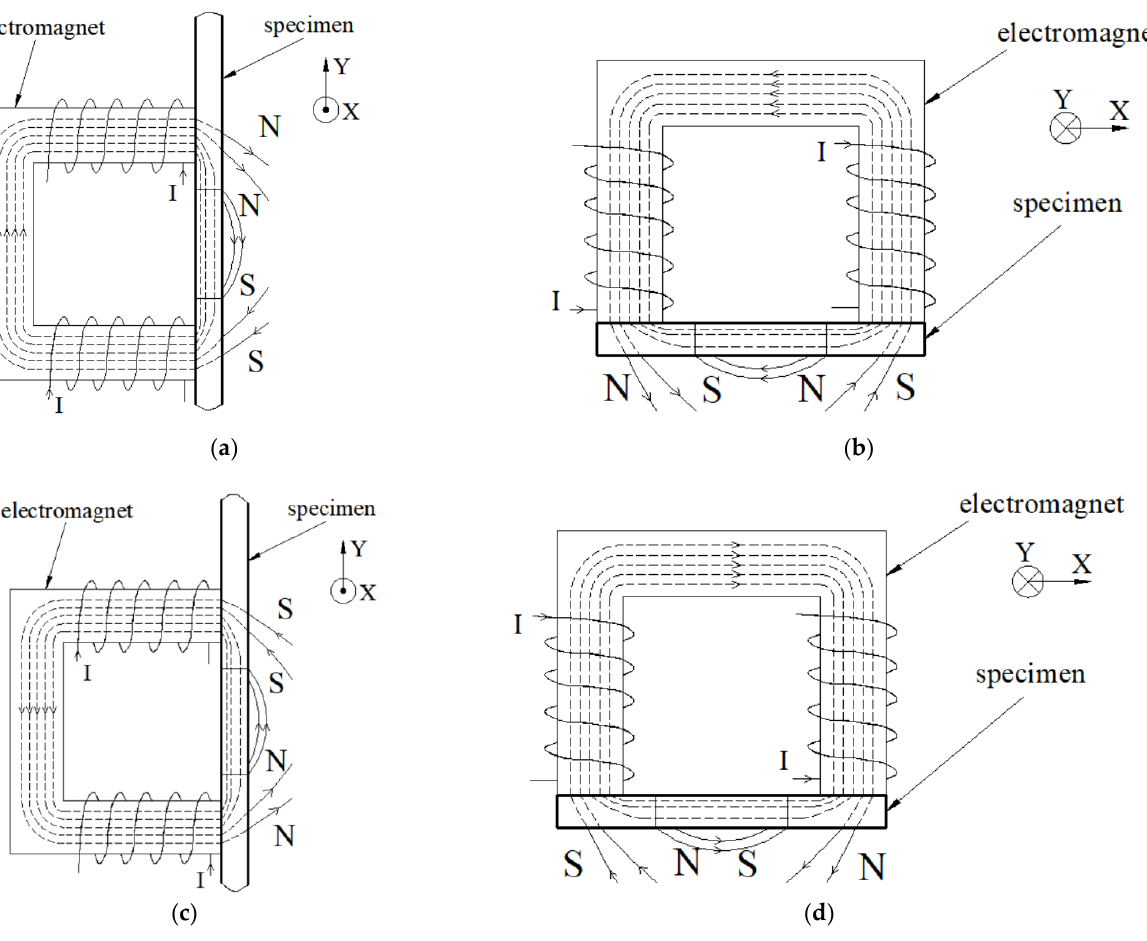
Figure 6. Distribution of the magnetic flux and magnetic pole of the measured area when the angle between the DC magnetic field and stress is: ( a ) 0°; ( b ) 90°; ( c ) 180° ; ( d ) 270°.